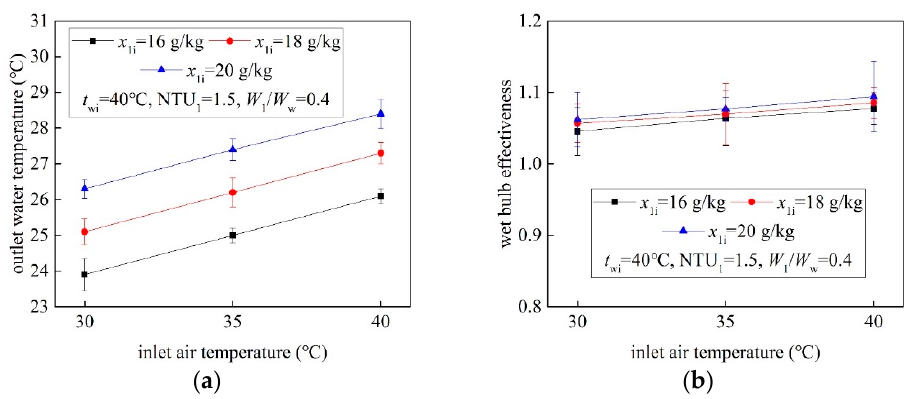
Figure 7. Impact of the inlet air temperature on the performance of the MCT: ( a ) t 1i vs. t wo ; ( b ) t 1i vs ε WB .